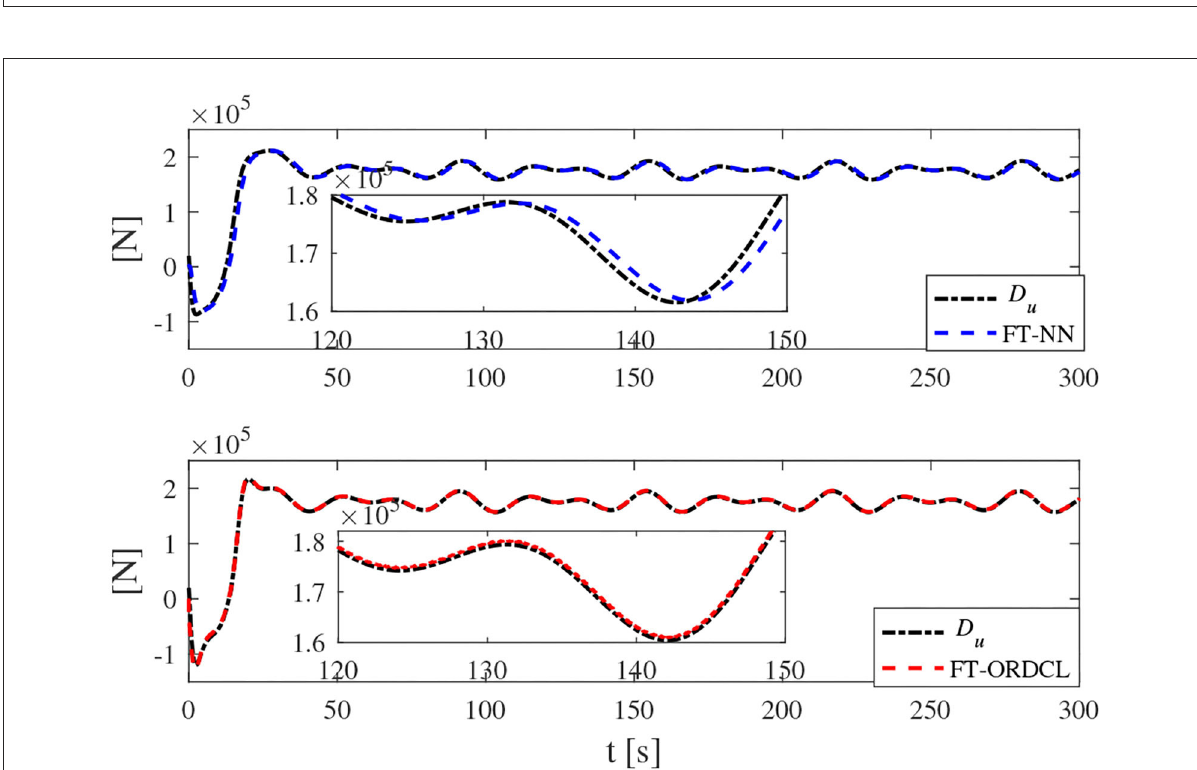
FIGURE3 D u and its estimation in Case